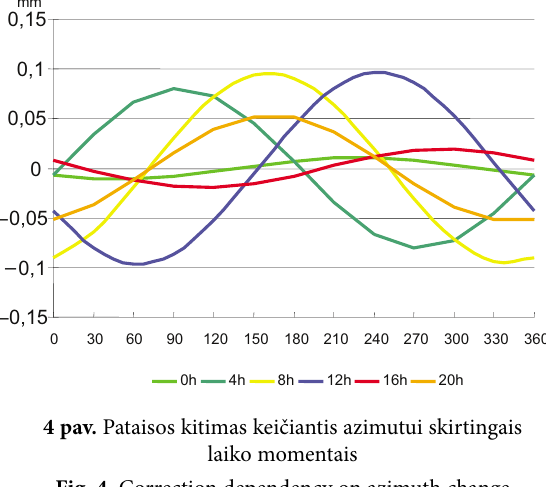
Fig. 2. Cange of lunisolar correction at different Moon phases Iš tyrimo rezultatų matyti, kad didžiausia pataisa esti jaunaties bei pilnaties meto, t. y. sizigijų meto, o delčios ir priešpilnio – aukščių skirtumo pokytis sumažėja, nes dangaus kūnų poveikis priešingų krypčių. Pataisa vienam kilometrui gali kisti nuo 0,006 mm iki 0,102 mm esant jaunačiai, nuo 0,003 mm iki 0,074 mm – pilnačiai bei nuo 0,011 mm iki 0,061 mm esant delčiai ir nuo 0,012 mm iki 0,054 mm – priešpilniui.